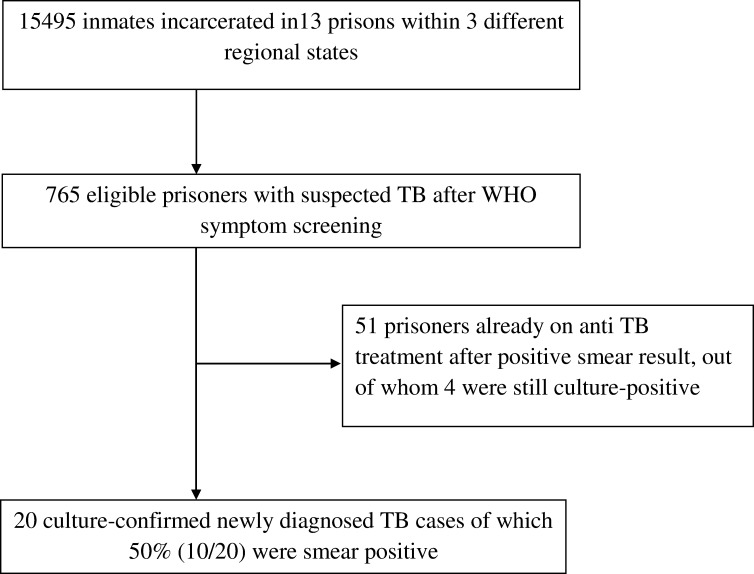
Overall study flow.Total prisons included, inmates screened, identified suspects and detected TB cases were presented by absolute number.